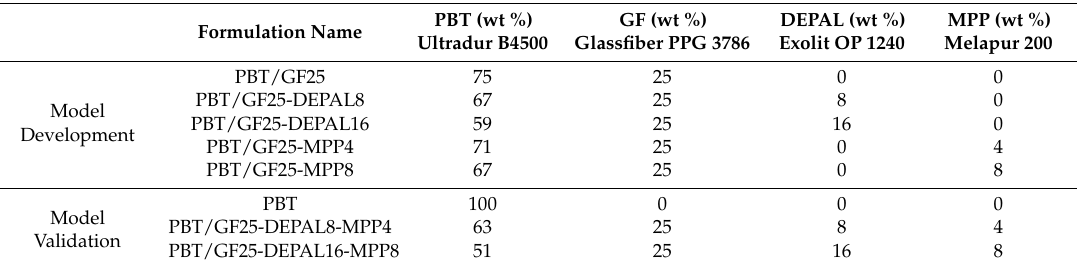
Table 1. Composition of tested